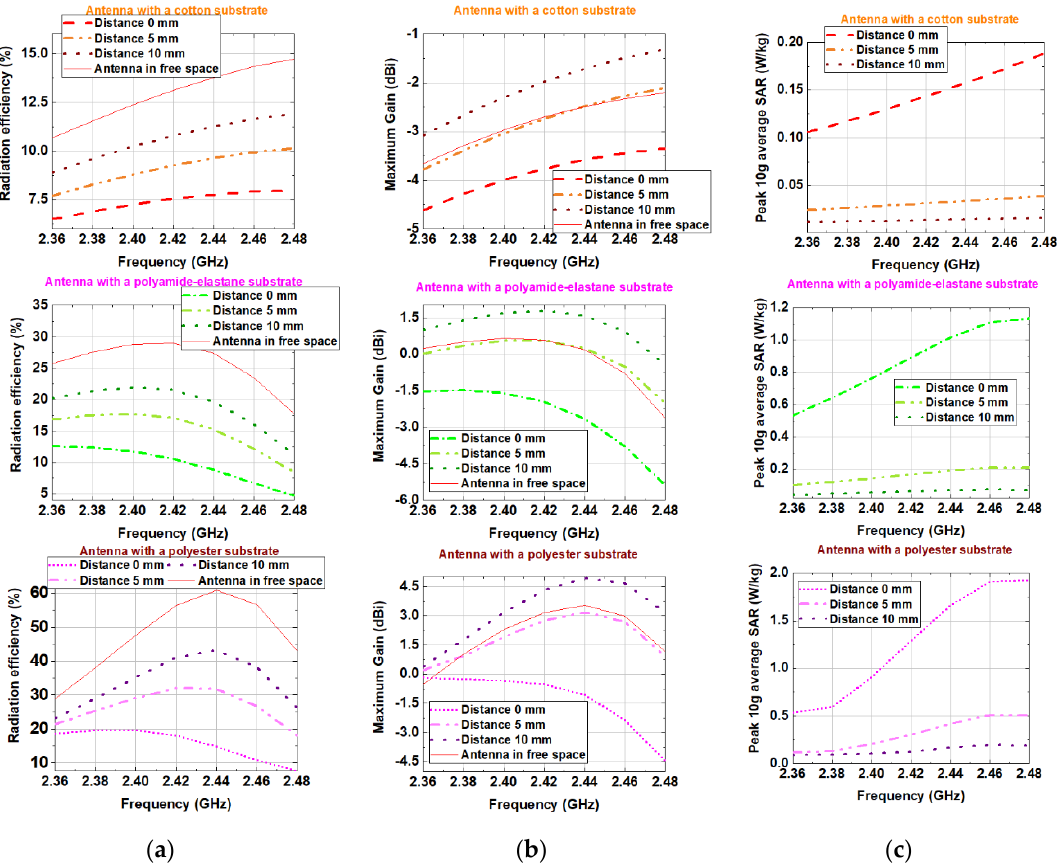
Figure 13. Simulated: ( a ) Radiation efficiency; ( b ) Maximum gain; ( c ) Peak 10 g average SAR versus frequency. Table 2. Maximum allowable net input power which satisfies the ICNIRP restriction of 2 W/kg for peak 10 g average SAR in the homogeneous phantom at 2.48 GHz. Distance, mm